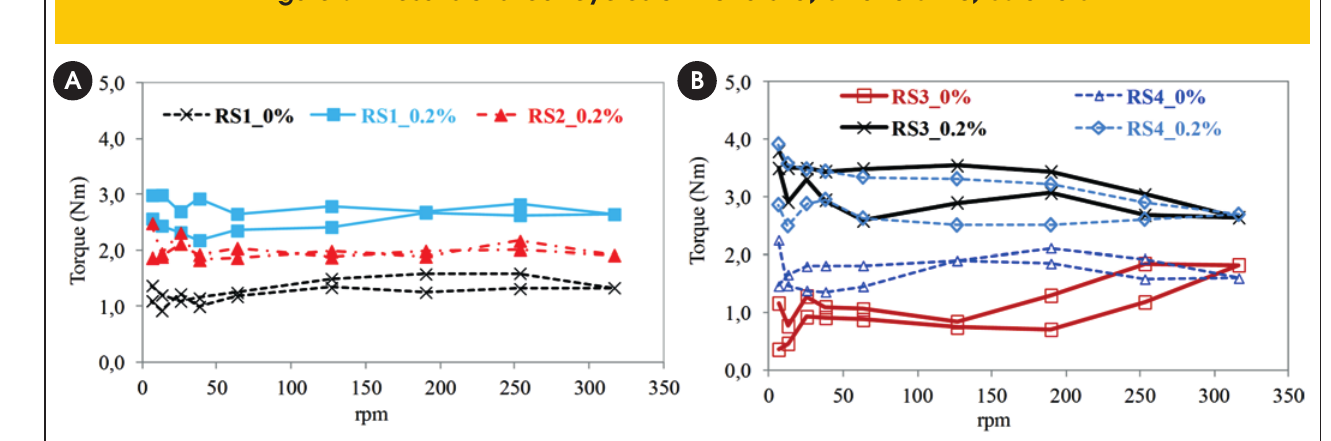
Figure 8 – Results of shear cycles of mortars. a) S1 and S2. b) S3 and